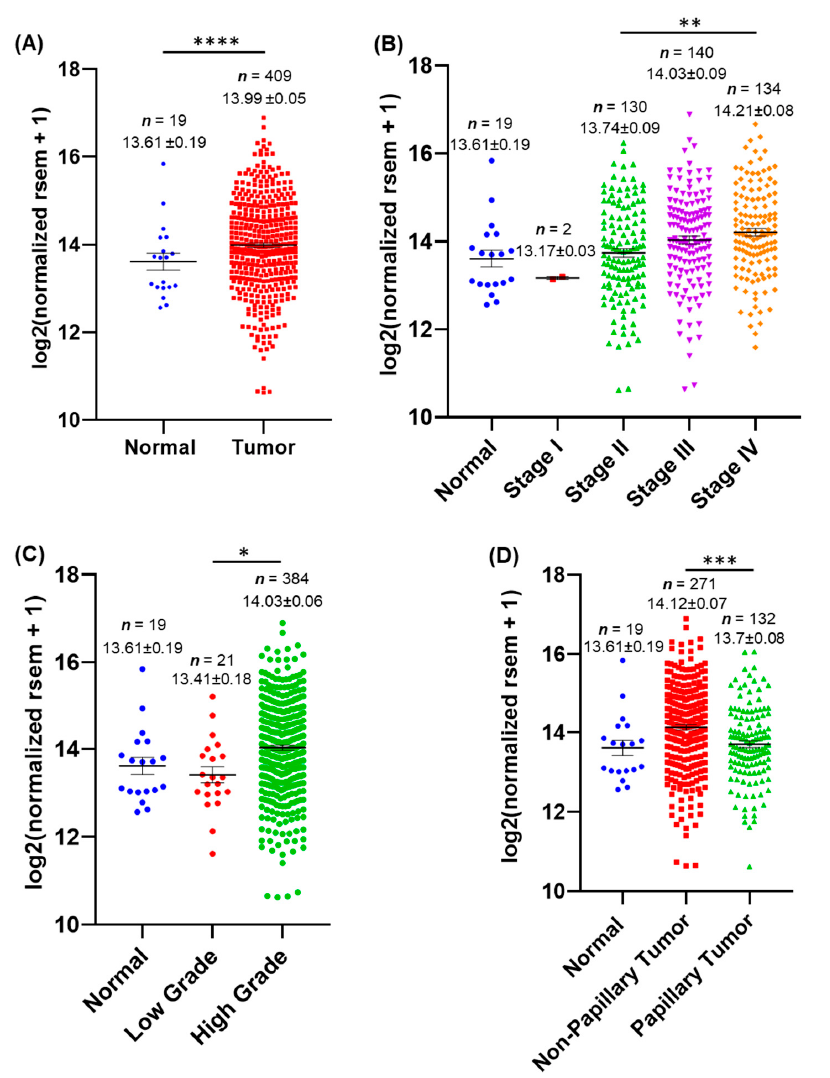
Figure 1. Analysis of AnxA2 mRNA expression and its clinical association in BLCA tumors from TCGA database. ( A ) Scatter plot analysis showing the AnxA2 mRNA expression in normal tissue ( n = 19) and tumor tissue ( n = 409) samples obtained from the TCGA-BLCA RNAseq database. Statistical analysis was performed using a two-tailed Student’s t -test. **** indicates p < 0.0001. Scatter plot analysis of AnxA2 mRNA expression in TCGA-BLCA patients based on stage ( B ), grade ( C ), and tumor histology ( D ). Statistical analyses were performed using either student’s t -test or one-way ANOVA followed by Tukey’s multiple comparison test. (*, p < 0.05; **, p < 0.01; ***, p <